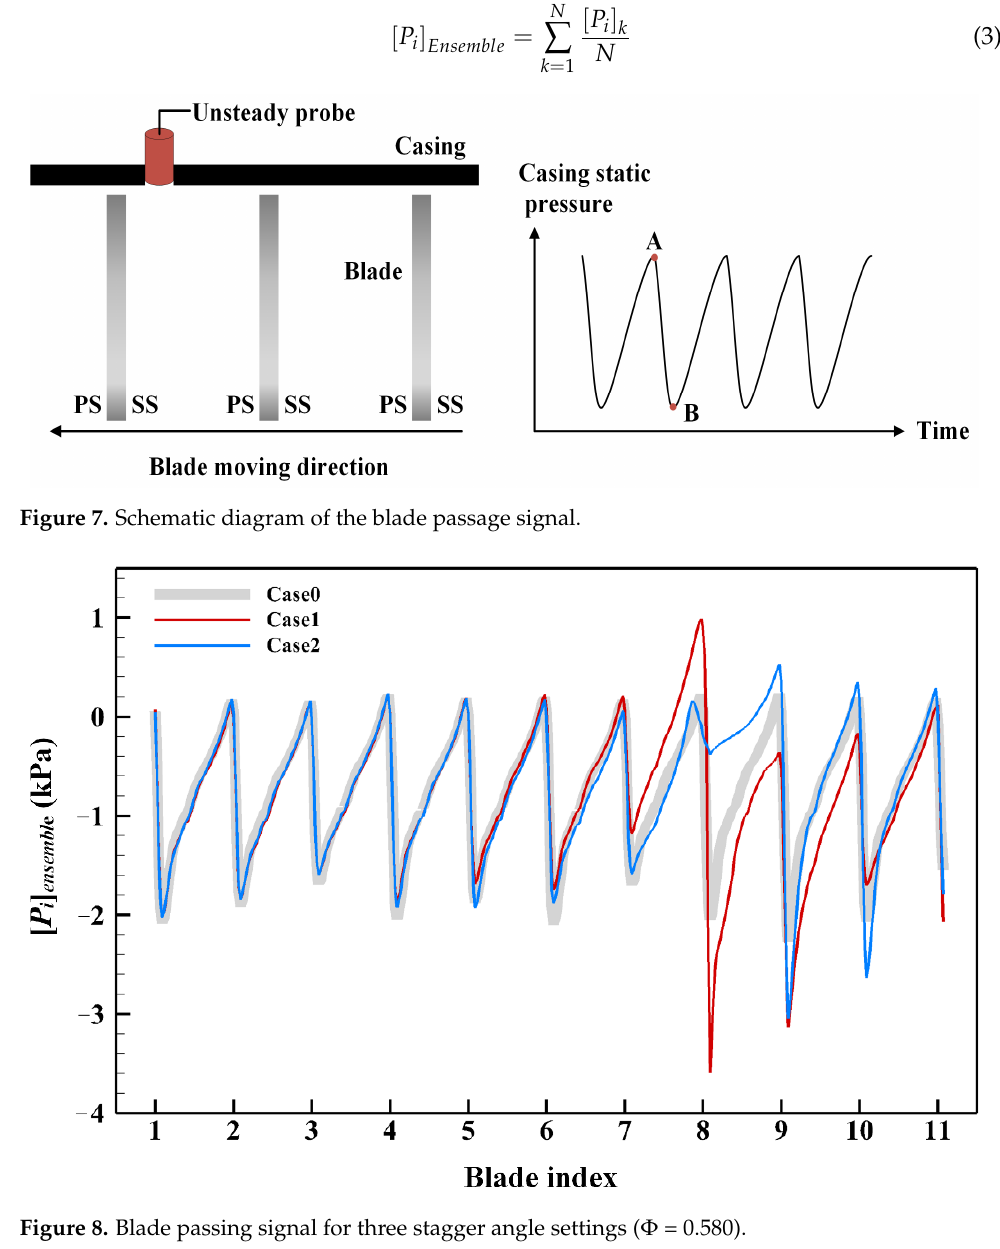
Figure 7. Schematic diagram of the blade passage signal.